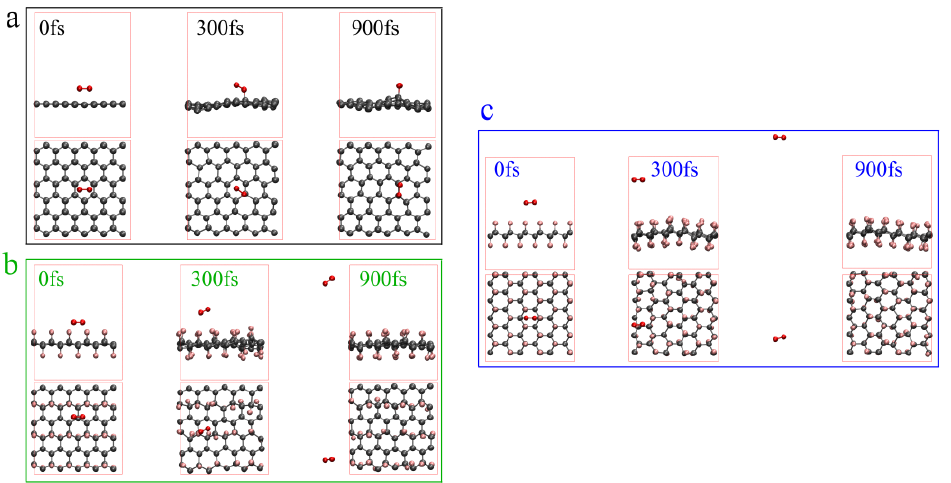
Figure 8. AIMD trajectories at 2000 K with a CSVR thermostat and 0.1 fs step-size. ( a ) Oxygen molecules near the graphene. ( b ) Oxygen molecules near the half-fluorinated graphene. ( c ) Oxygen molecules near the whole-fluorinated graphene.